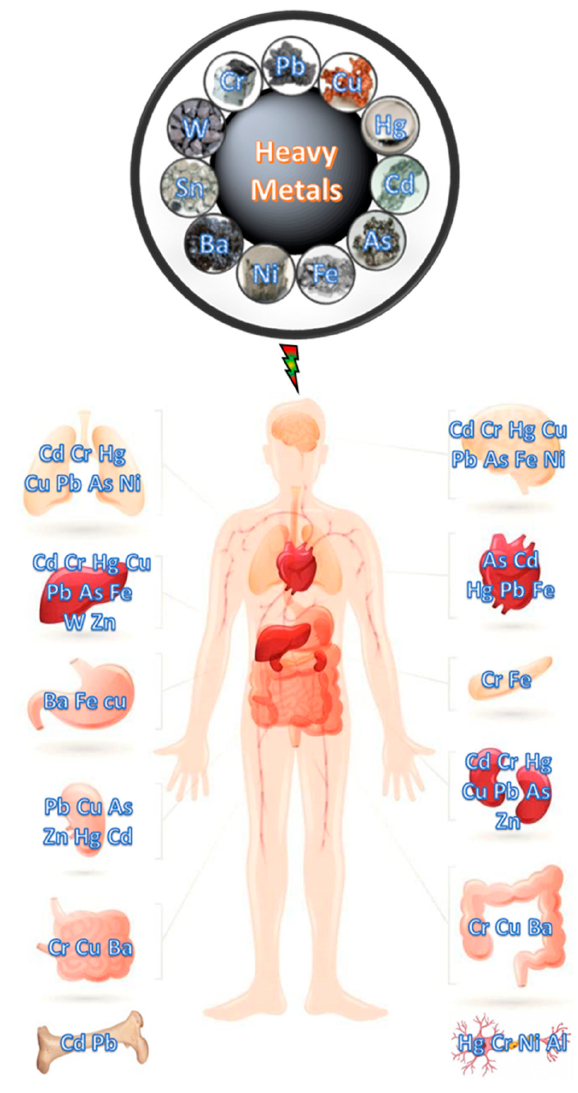
Figure 1. Illustration of human organs affected by the excess of heavy metal.